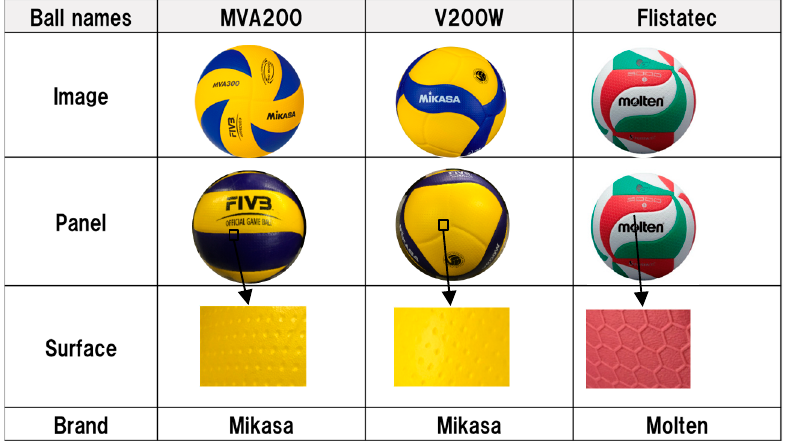
Figure 1. Three types of target volleyballs.